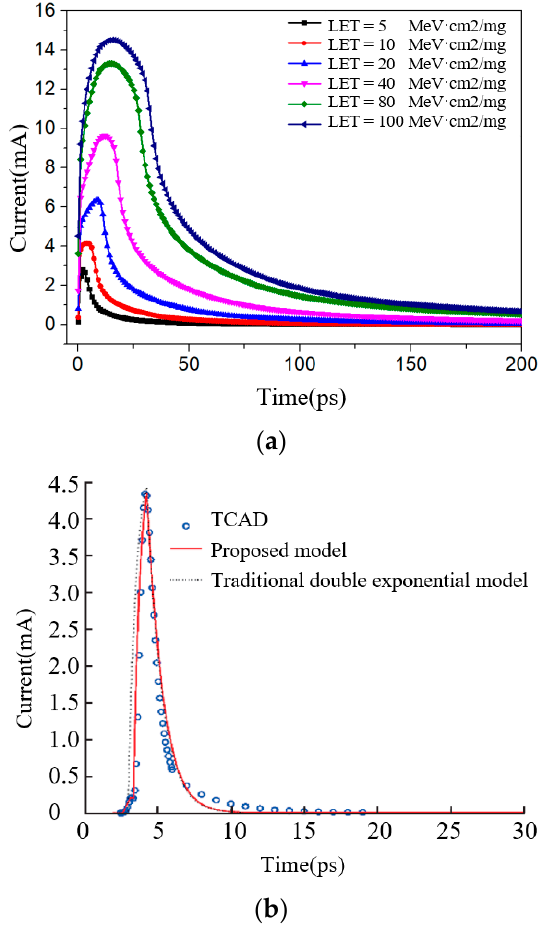
Figure 8. Current source model for SET in different processes: ( a ) 130 nm process; ( b ) 14 nm process.